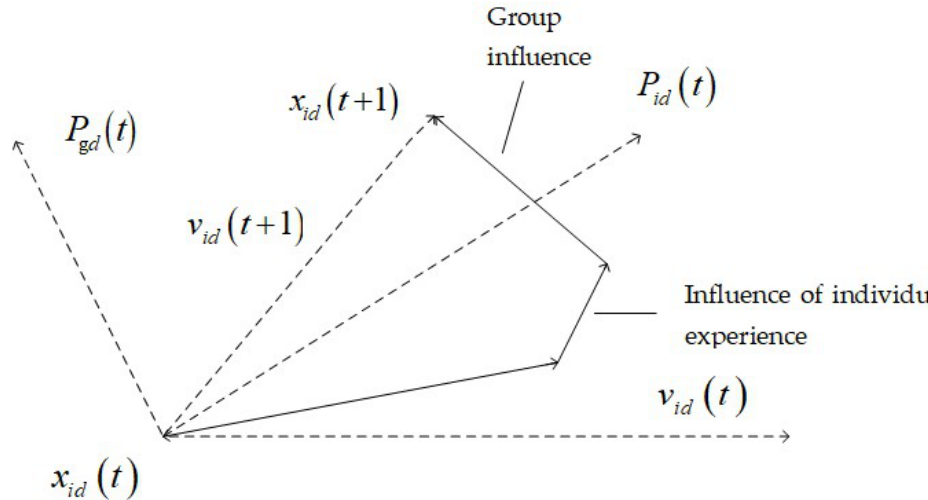
Figure 1. Diagram of particle position update.